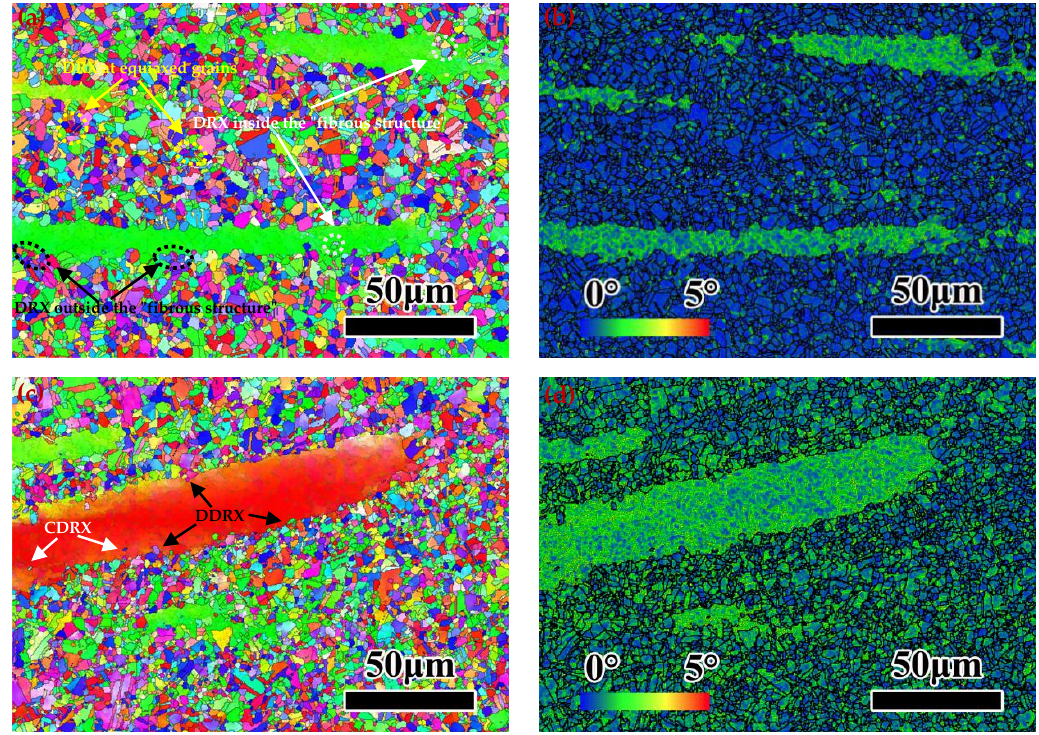
Figure 5. ( a ) IPF map of the BM; ( b ) KAM map of the BM; ( c ) IPF map of the PDMZ; ( d ) KAM map of the PDMZ.